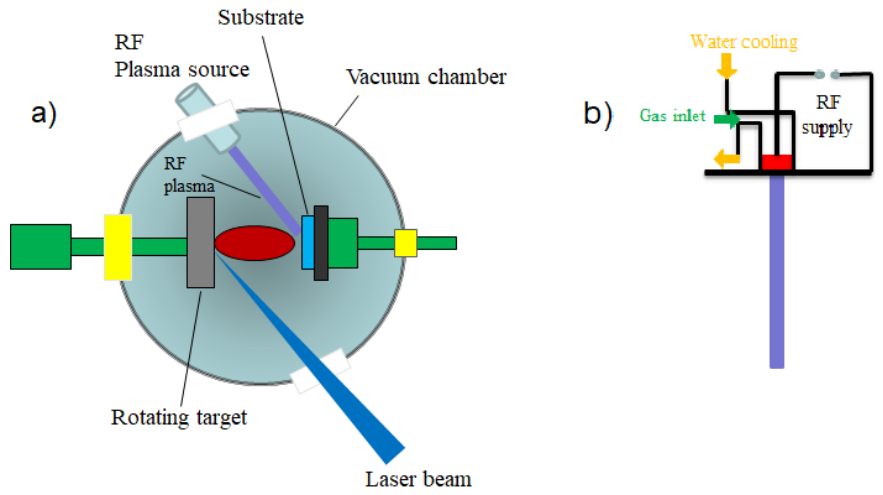
Figure 6. The experimental setup of radiofrequency (RF)-assisted PLD ( a ) and RF plasma source ( b ) Adapted from reference [86].